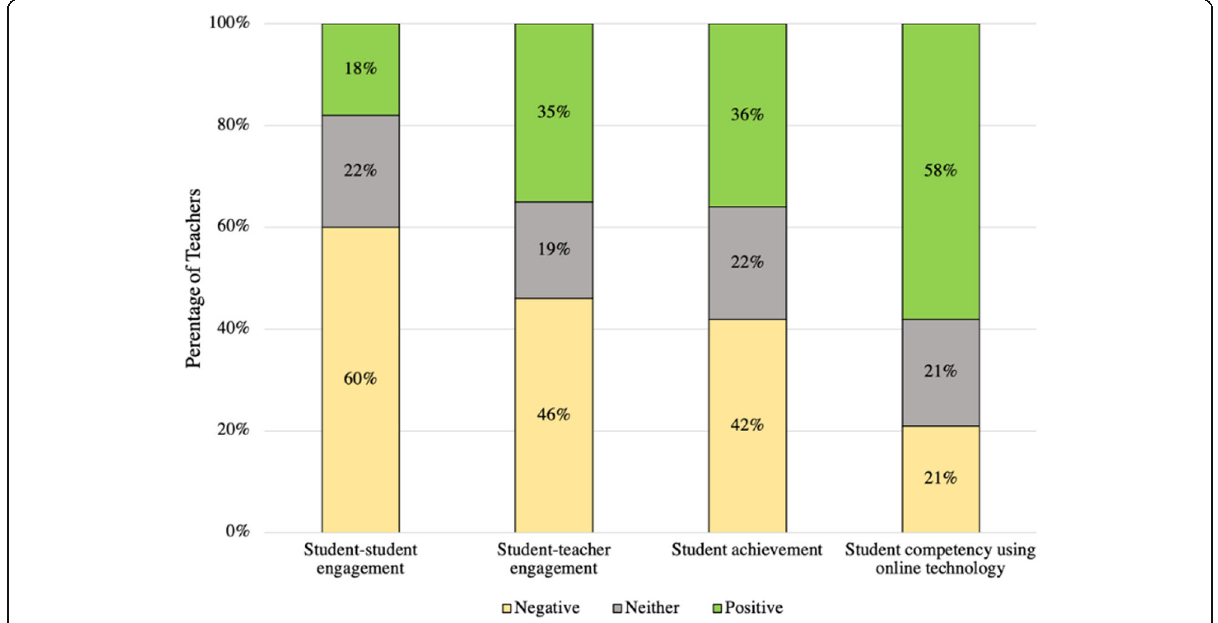
Fig. 6 Teachers ’ account of online teaching impact on student